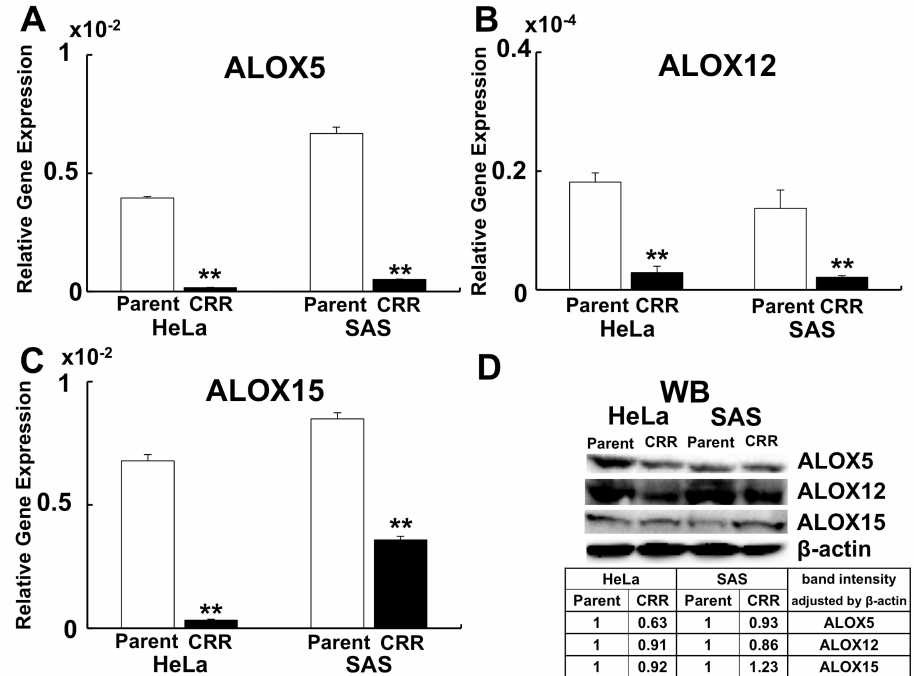
Figure 5. Expression of ALOXs in CRR cells. ALOX5 , 12, and 15 expressions in parent and CRR cells were detected using qPCR ( A – C ) and western blotting ( D ). A: Gene expression of ALOX5 . ( B ) Gene expression of ALOX12 . C: Gene expression of ALOX15 . **: p < 0.01 using Student’s t -test. Each qPCR was performed 3 times. Gene expressions of ALOX5 , 12 , and 15 were all significantly down-regulated in CRR cells. ( D ) Western blotting of ALOX5 , 12 , and 15 . The table shows the expression level of each ALOX s in CRR cells. After correcting the intensity of each band by the expression of β -actin, the value is shown with the parent strain as 1. The protein expressions of ALOX5 and 12 were down-regulated in CRR cells. However, ALOX15 was not down-regulated in protein level in SAS CRR cells.